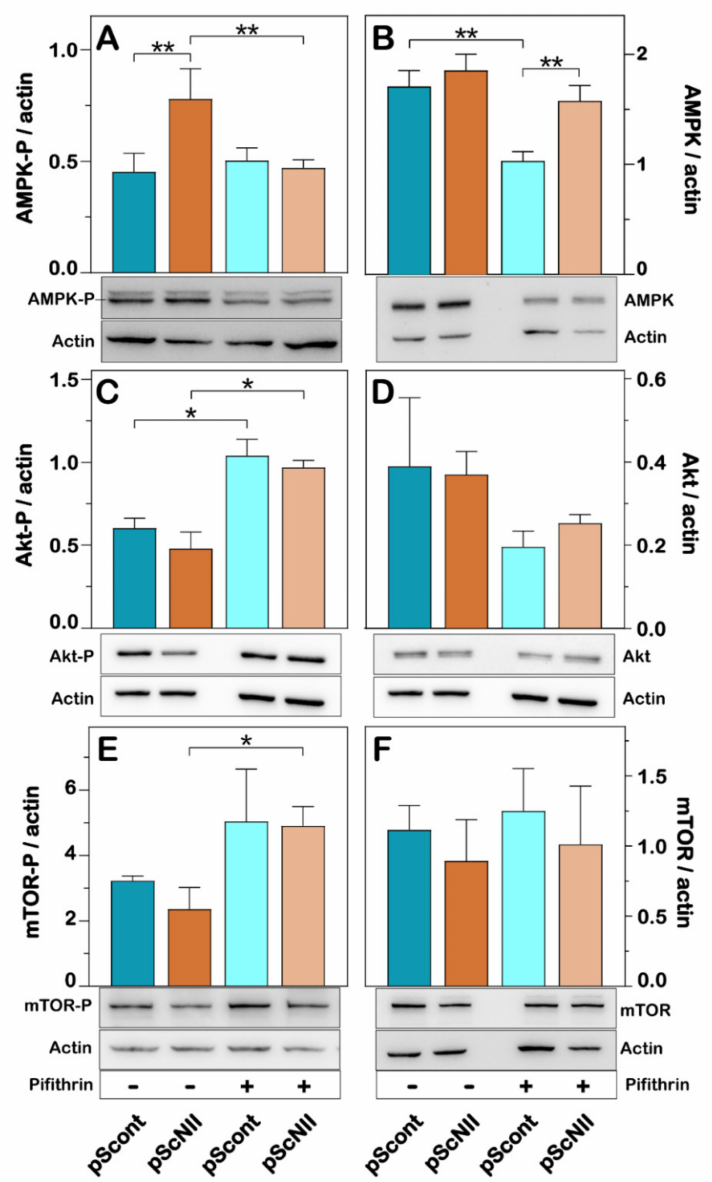
Figure 5. Effect of cN-II silencing on the expression and activation of AMPK, Akt and m-TOR. The subfigures are representative images of the densitometries shown in the bar graphs for AMPK-P ( A ), total AMPK ( B ), Akt-P ( C ), total Akt ( D ), mTOR-P ( E ), and total mTOR ( F ). NCI-H292. pScont and pScNII cells were cultured with or without 10 µ M pifithrin- α for 48 h and expression of the proteins was analyzed as described in Materials and Methods. β -actin was used as loading control. The ratio between the intensity of the different protein bands and that of the corresponding actin was calculated and the results are expressed as the mean ± SD of three independent experiments. * p < 0.05, ** p <